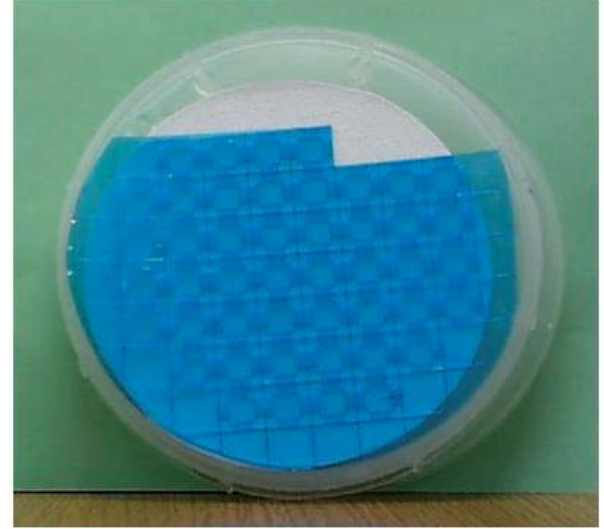
Figure 3. An image of a 4-inch patterned pyrex